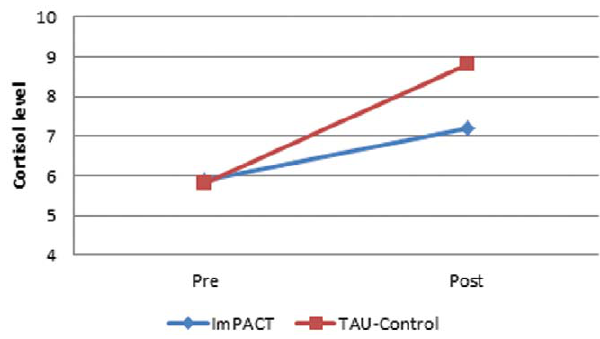
Figure 3. Illustration of the differential increase in heart rate from the baseline to the first apprehension period (when reading the mission) and the second apprehension period (when waiting in front of the curtain wall) phases of a live first aid simulation.